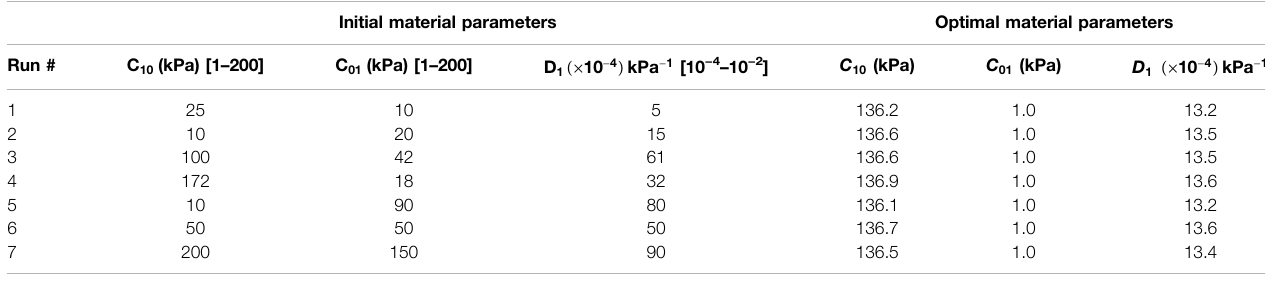
TABLE 1 | Sets of initial estimates and converged optimal material parameters for the homo/iso/hyper case. In order to avoid local minimum, the optimization routine was repeated from seven different starting points. Initial material parameters Optimal material parameters